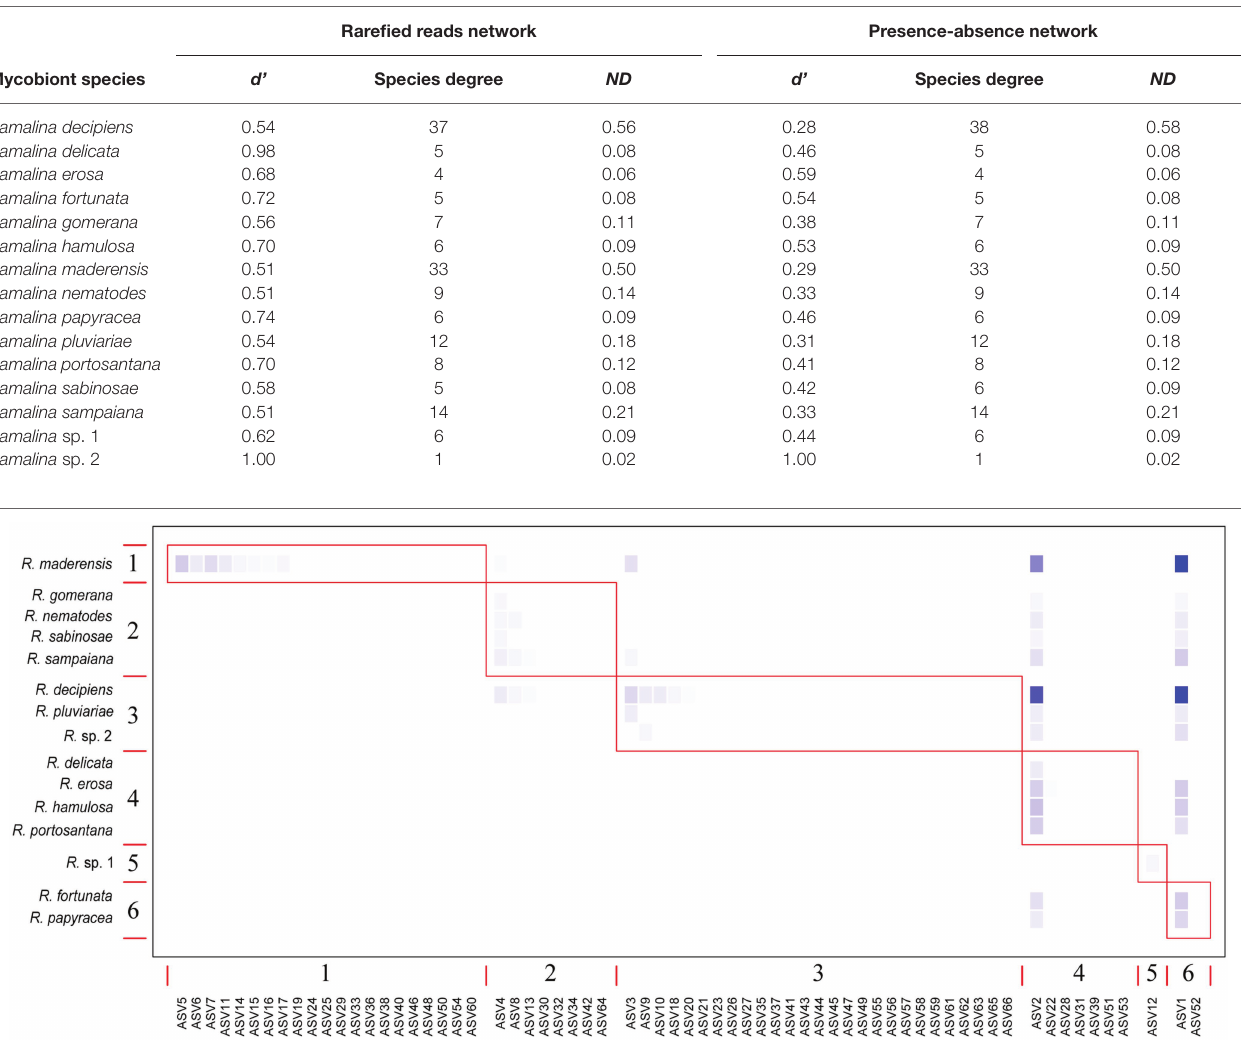
TABLE 3 | Summary of specialization parameters of the bipartite networks based on the sum of the rarefied reads of the thalli of each species and the conversion of the abundance of ITS2 reads of the thalli to presence-absence data. Rarefied reads network Presence-absence network Mycobiont species